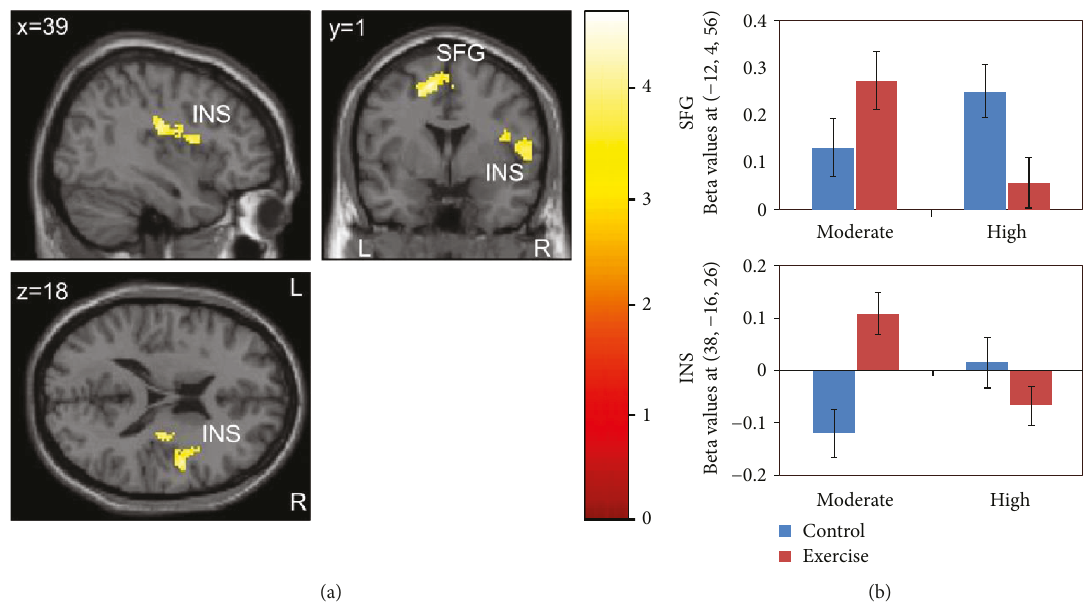
Figure 2: Brain activation during the Go/No-go task for the contrast hits : (a) activation speci fi c to moderate ( exercise − control ) – high ( exercise − control ); (b) mean beta values of peak coordinates with standard error for each group and condition separately. Activation di ff erences were found in two clusters with peak activation in the left superior frontal gyrus (SFG) and right insula (INS). p < 0 05 (FWE- corrected on cluster level, initial voxel threshold 0.001 uncorrected). Table 3: Brain activation during hit trials of the Go/No-go task. Group,